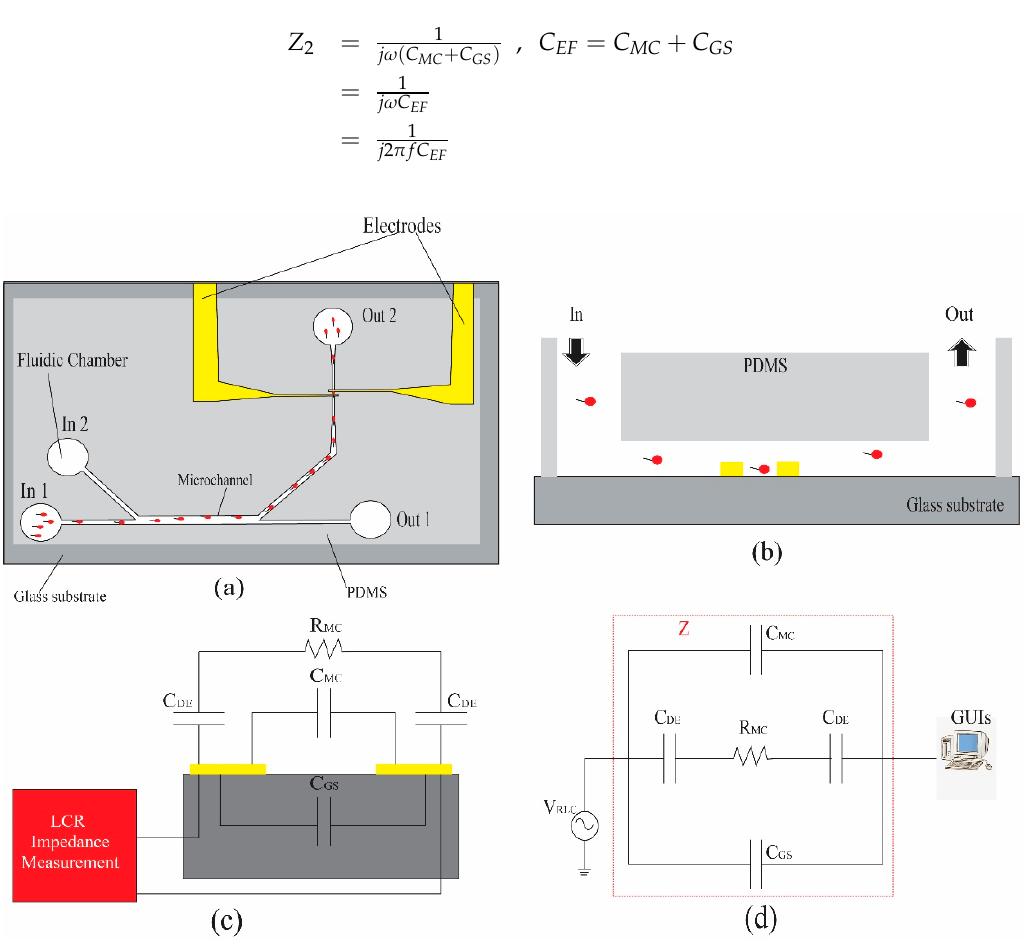
Figure 3. A schematic of the microfluidic chip sorting, counting, and detecting sperm: ( a ) top view and ( b ) sectioned front view. ( c ) Electrical equivalent circuit of the microfluidic sperm counting device. ( d ) The measurement setting was used for sperm and particle detection.